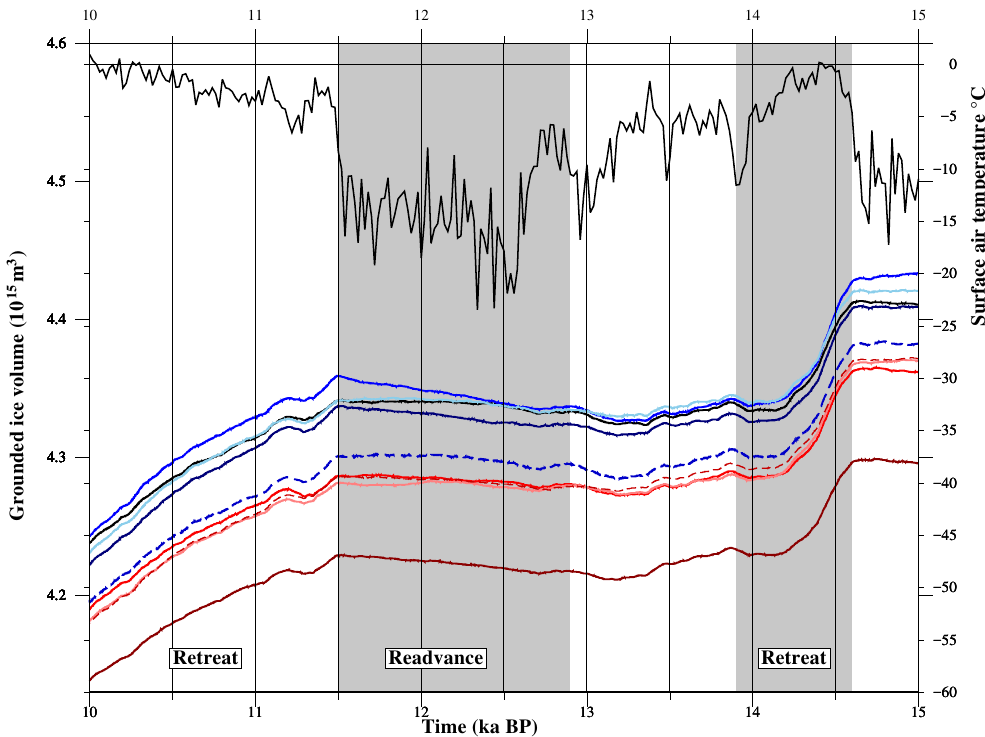
Figure 6. Comparison of the grounded ice volume (10 15 m 3 ) from the nine optimum simulations (see Table 3 for colours) and the surface air temperature forcing ( ◦ C) (black line; Fig. 2a) from 15 to 10ka BP. Highlighted are the timings of the retreat–readvance–retreat of the SW margin (red box; Fig. 1), the spatial pattern of which is illustrated for Av A s + AvSSM1 (light red line) in Fig. 7. Results for the NW are illustrated in Fig.